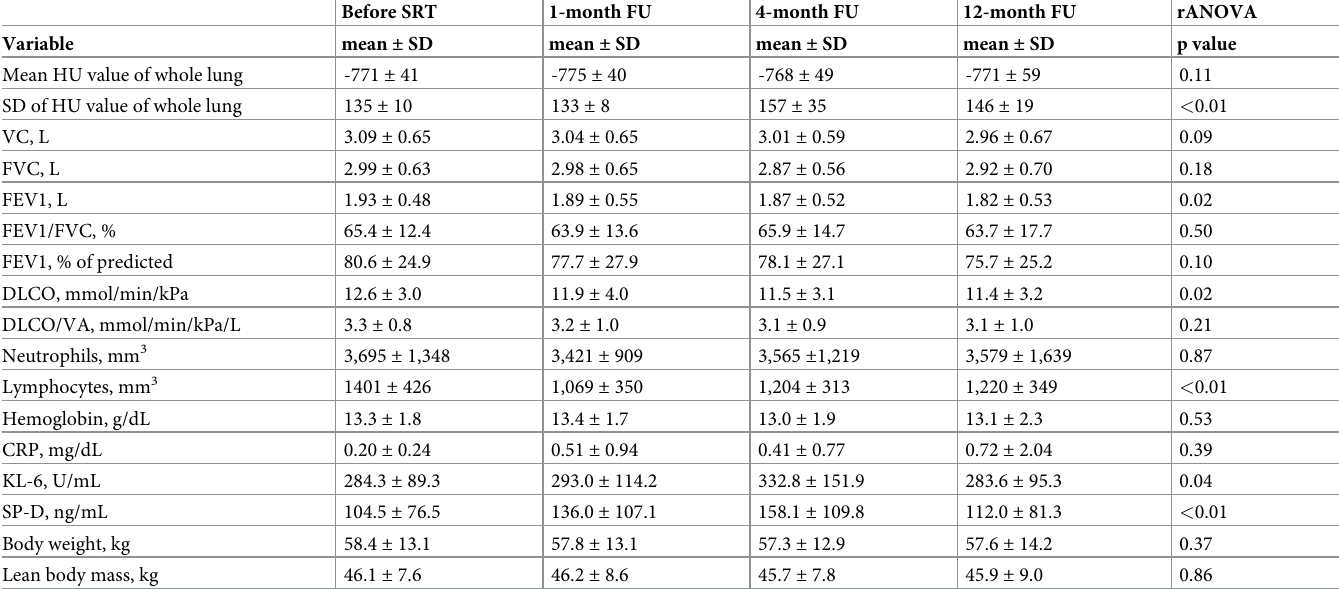
Table 2. Baseline data and longitudinal analyses of the